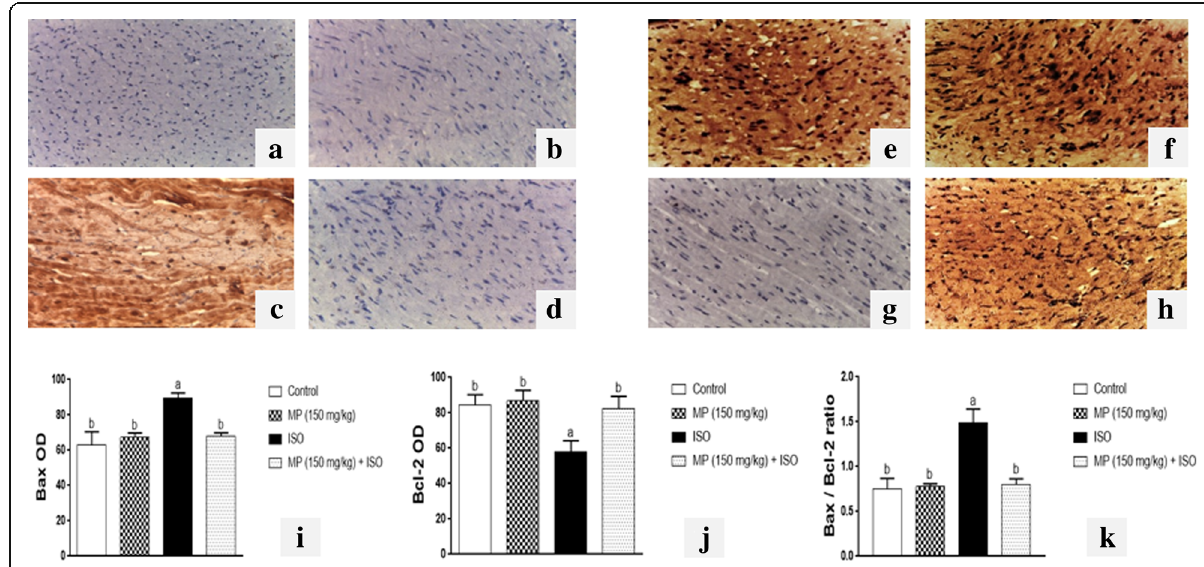
Fig. 5 Immunohistochemical analysis of Bax and Bcl-2 in heart sections (magnification × 400). a and e Control group showing minimal Bax expression and maximal Bcl-2 expression respectively. b and f MP group showing minimal Bax expression and maximal Bcl-2 expression respectively. c and g ISO-intoxicated group showing extensive heavy Bax expression and minimal Bcl-2 expression respectively. d and h MP- pretreated group showing mild Bax expression and extensive Bcl-2 expression respectively. i and j Quantitative image analysis for immunohistochemical staining of Bax and Bcl-2 respectively expressed as optical densities (OD) across 10 different fields for each rat section. k The ratio of Bax to Bcl-2 expression in the heart of different groups. Data are presented as mean ± SD ( n = 10); a or b: significantly different from control or ISO groups respectively at P < 0.05 using one-way ANOVA followed by Tukey as post hoc test. MP methyl palmitate, ISO isoproterenol, Bax Bcl-2-associated X, Bcl-2 B cell lymphoma